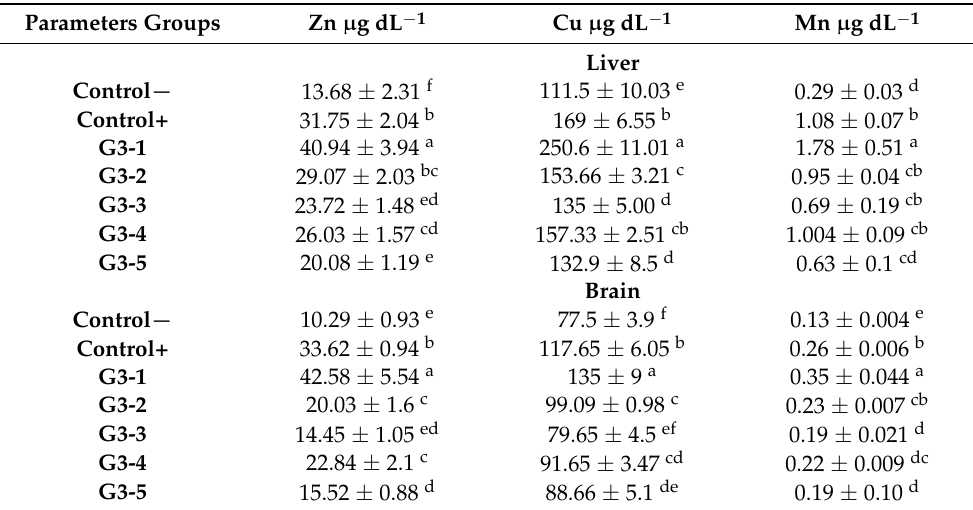
Table 8. Effect of wheat and barley grass on changes in Cu, Mn, and Zn in rat serum and liver tissues exposed to those toxic metals (mean ±